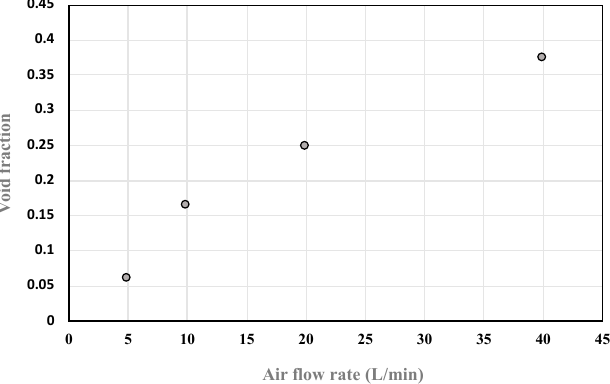
Figure 27. Average void fraction data points plotted versus the air flow rate.